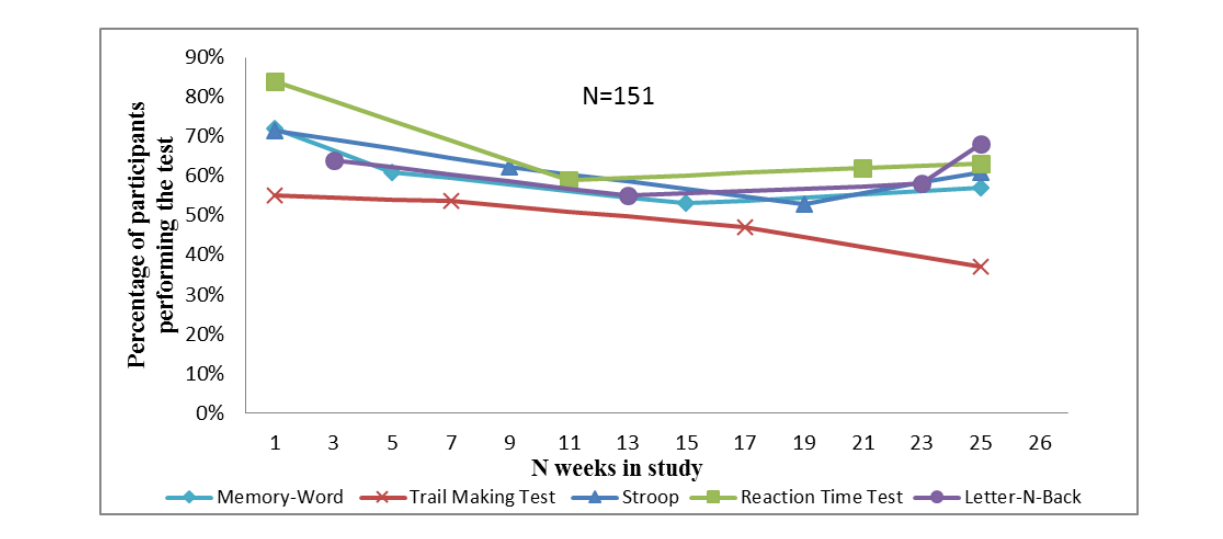
Figure 2. Adherence to smartphone-based cognitive